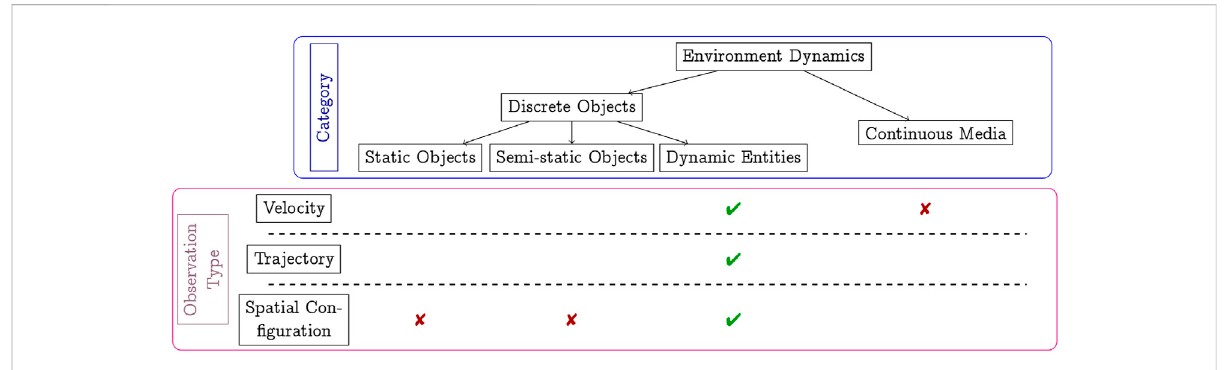
FIGURE 2 The fi gure shows the different categories of dynamics, and how they are observed (and mapped in consequence). The crosses and ticks show how different types of dynamics can be observed. The green ticks denote the areas of interest for this